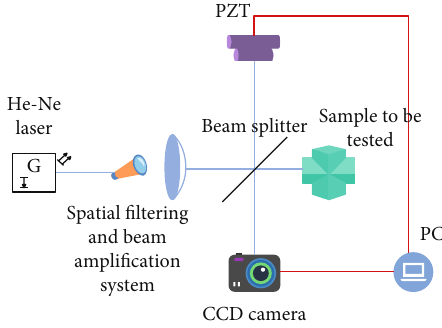
Figure 1: Animation light interferometry